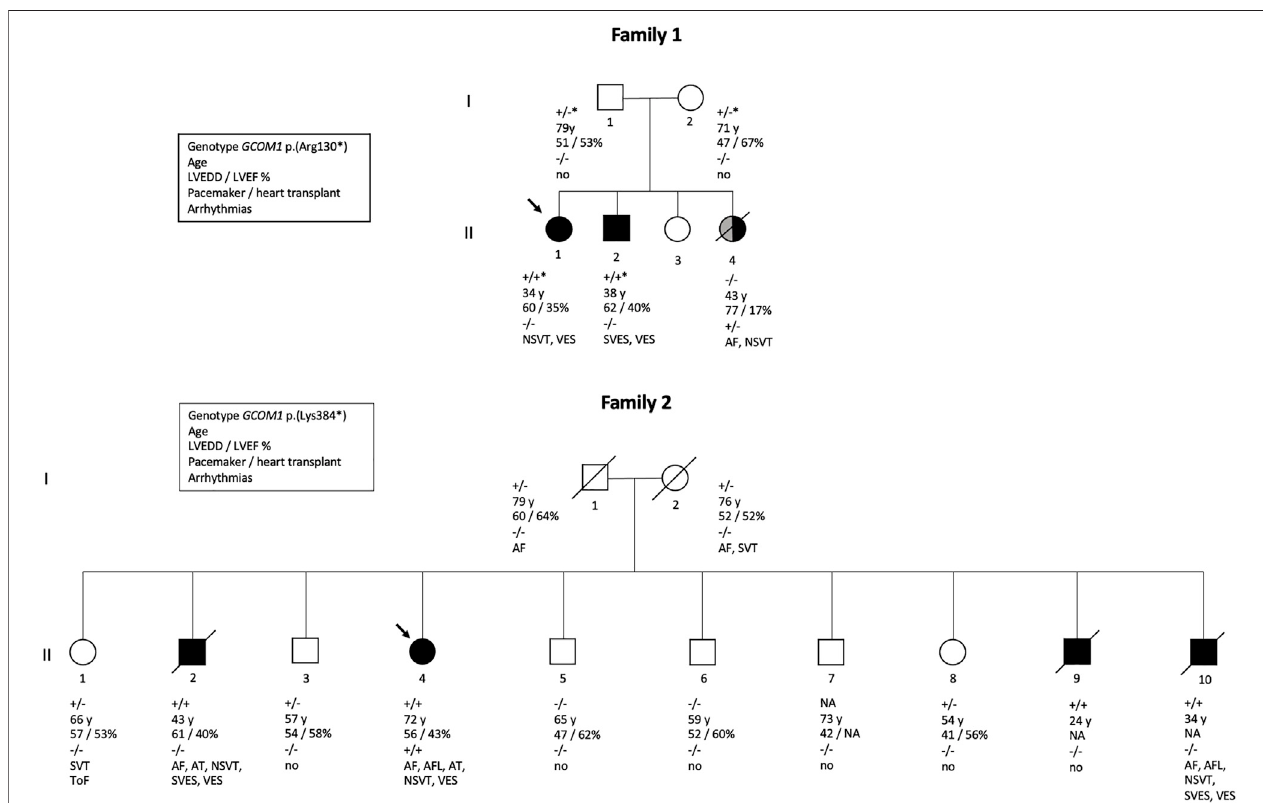
FIGURE2| Pedigrees oftwofamilies.FamilyoneisaffectedwithGCOM1c.388C > T,p.(Arg130*)variant, Family2with GCOM1 c.1150 A > T,p.(Lys384).Circles representwomen,squaresmen.Blacksymbolsrepresentindividualswhoful fi lcardiomyopathycriteria.Greysymbolrepresentscardiomyopathyofotheretiology.Arrow indicates proband. Genotypes: + /+ homozygous and + /- heterozygous for the GCOM1 c.1150 A > T, p.(Lys384*); + /+* homozygous and +/ − * heterozygous the for GCOM1 c.388C > T, p.(Arg130*), − / − wild type allele. Clinical features are listed below the symbols; Age – age at the time of clinical examination or at the time of death, LVEDD left ventricular end-diastolic diameter (mm), LVEF left ventricular ejection fraction (%), pacemaker/cardiac transplant: + indicates yes, – indicates no, ToF Tetralogy of